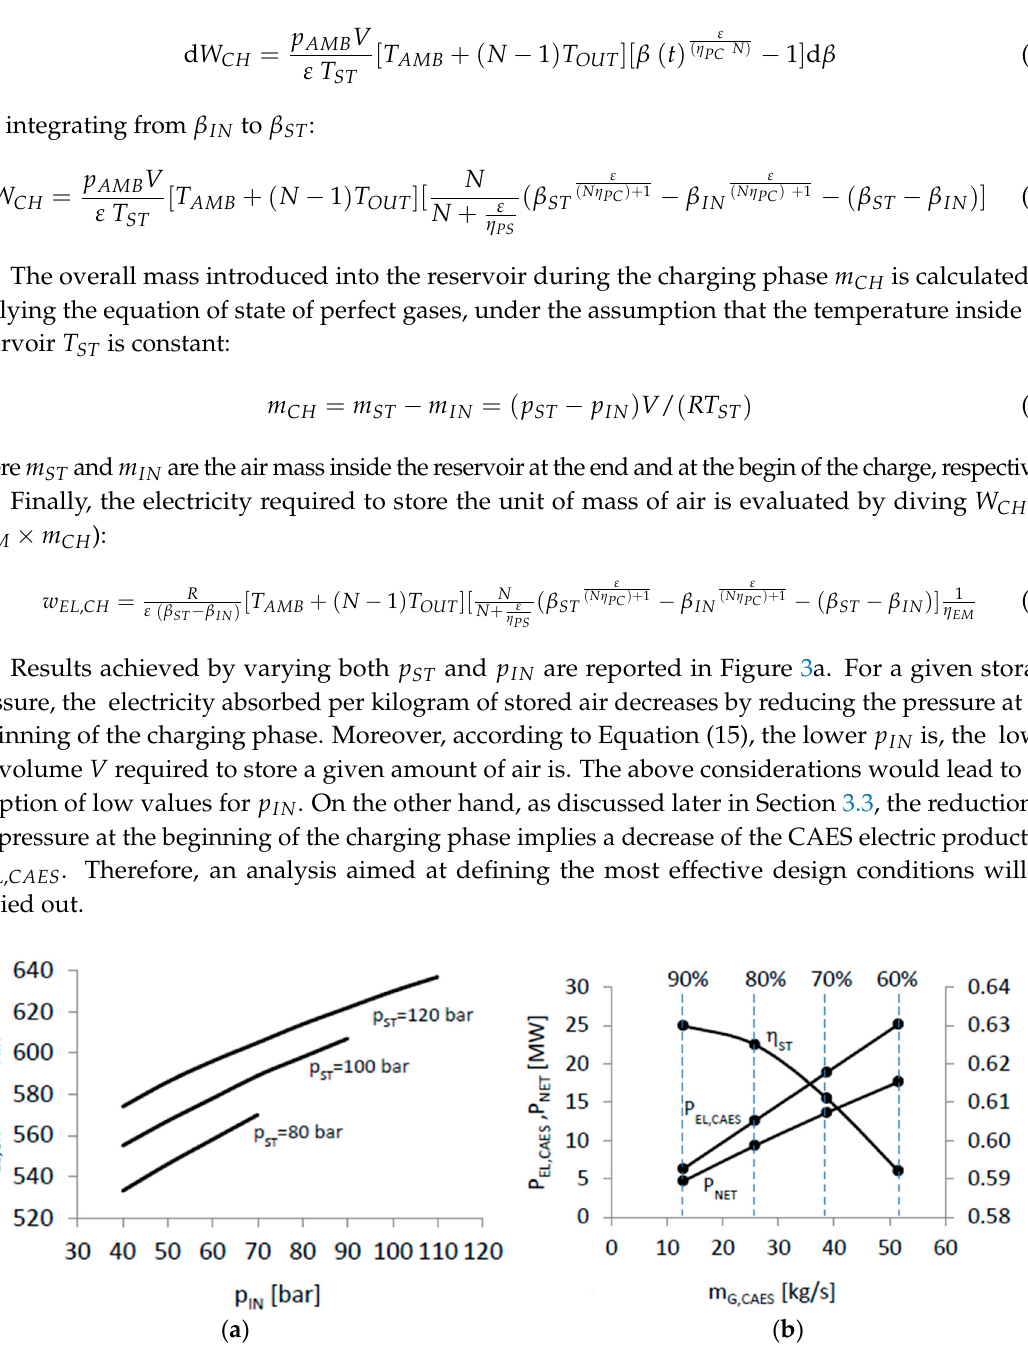
Figure 3. ( a ) Electricity absorbed per unit of mass during the charging phase; ( b ) CAES design point performance by varying the gas mass flow rate ( p ST = 100 bar, p IN = 60 bar). performance by varying the gas mass flow rate ( p ST = 100 bar, p IN = 60